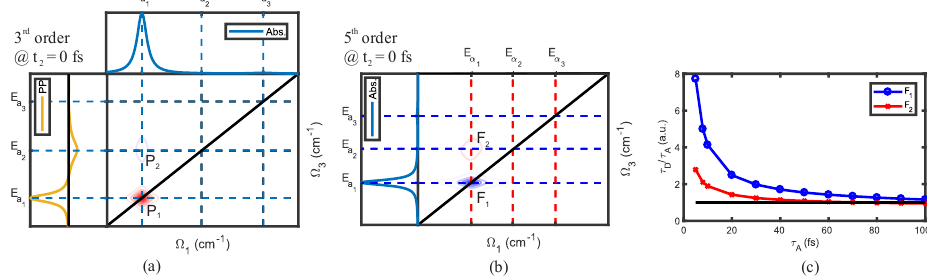
Fig. 2. Simulated absorption, pump probe and 2D-ES spectra of both 3 rd and 5 th order signals at t 2 = 0fs are depicted in (a) and (b). (c) Plot of the different decay times τ D obtained by fitting transients of peak F 1 and F 2 along t 2 by a mono- exponential decay for different annihilation rates τ A